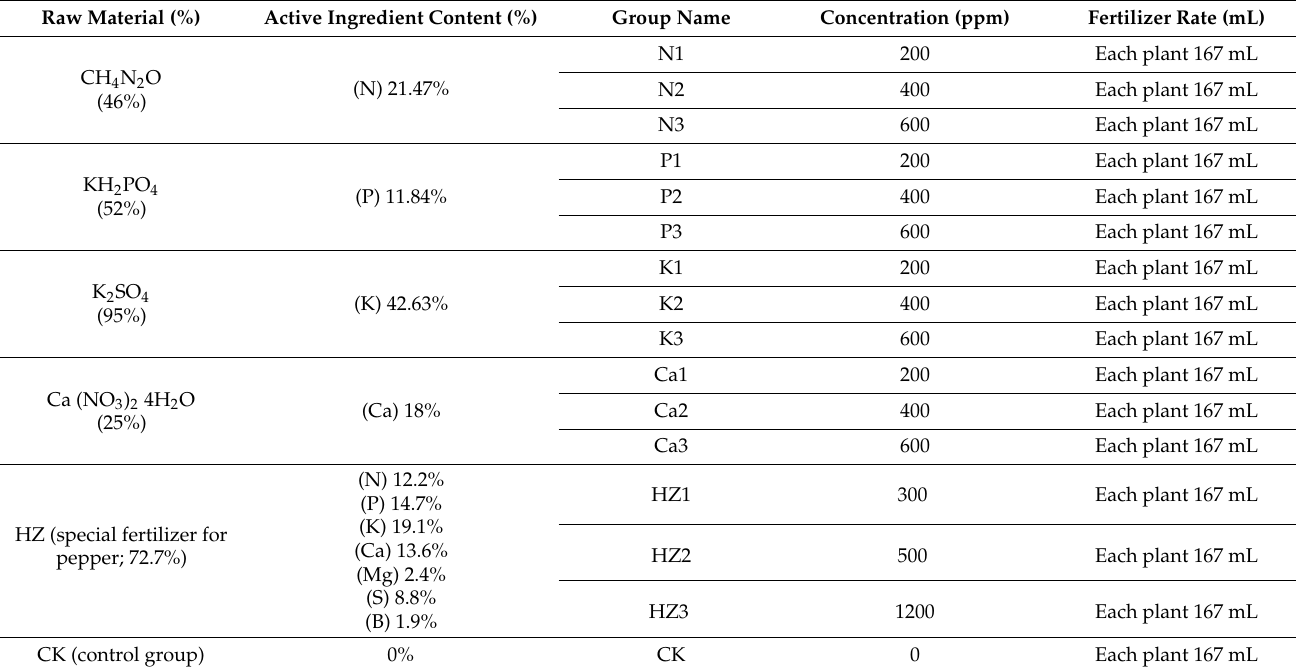
Table 1. Fertilizer Solution Configuration